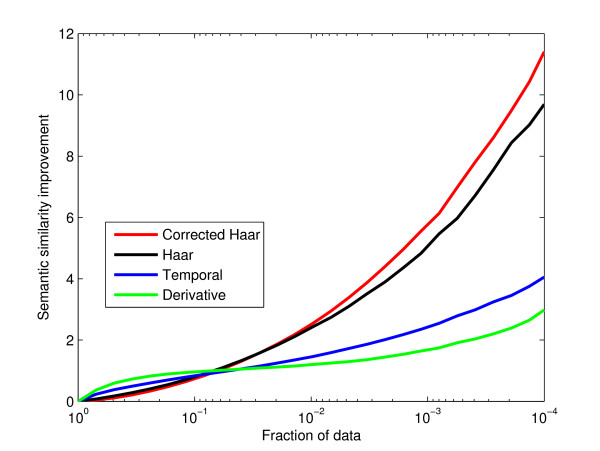
Semantic similarity of extreme basis coefficients. Starting from the left, only the more extreme coefficient values are retained. Corrected Haar values (red line) perform the best, followed by Haar values (black line), age segregated values (blue line), and last derivative basis set values (green line)